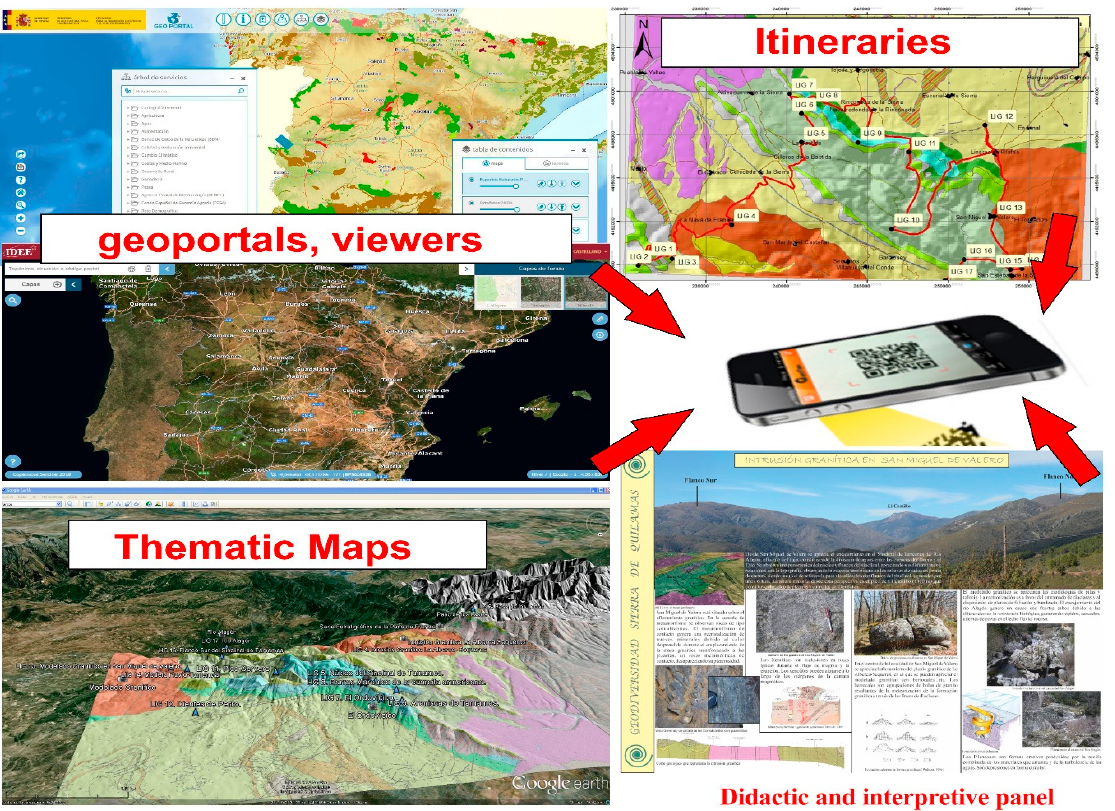
Figure 3. Graphical flowchart to understand the procedure and loading of layers in final implementation on smartphone.